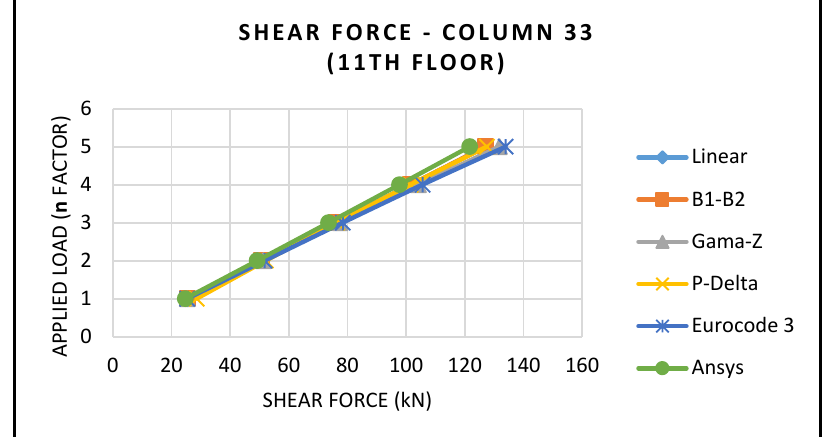
Figure 14 - Load - shear force relationship for column 33. Source: Authors